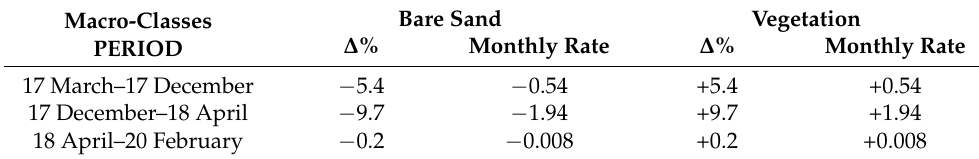
Table 5. Percentage difference in bare sand/vegetation cover between each subsequent